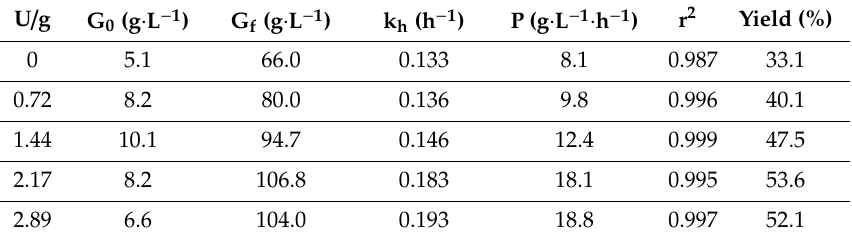
Figure 4. Evolution of RS concentration over hydrolysis time of fresh ESBPPs in 300 mL of citrate-phosphate bu ff er (pH 5, 0.05 M) at 50 ◦ C with an FFR of 15:55 and with addition of Celluclast ® (0, 0.72, 1.44, 2.17, and 2.89 U · g − 1 of dried fresh ESBPPs). Lines indicate theoretical values obtained from the kinetic model and symbols represent experimental values. Table 4. E ff ect of Celluclast ® supplementation (0, 0.72, 1.44, 2.17, and 2.89 U · g − 1 of dried fresh ESBPPs) on hydrolysis experiments performed at 50 ◦ C with an FFR of 15:55. G o : initial RS concentration, G f : theoretical maximum RS concentration, k h : hydrolysis rate (h − 1 ), and P: productivity (g · L − 1 · h − 1 ).